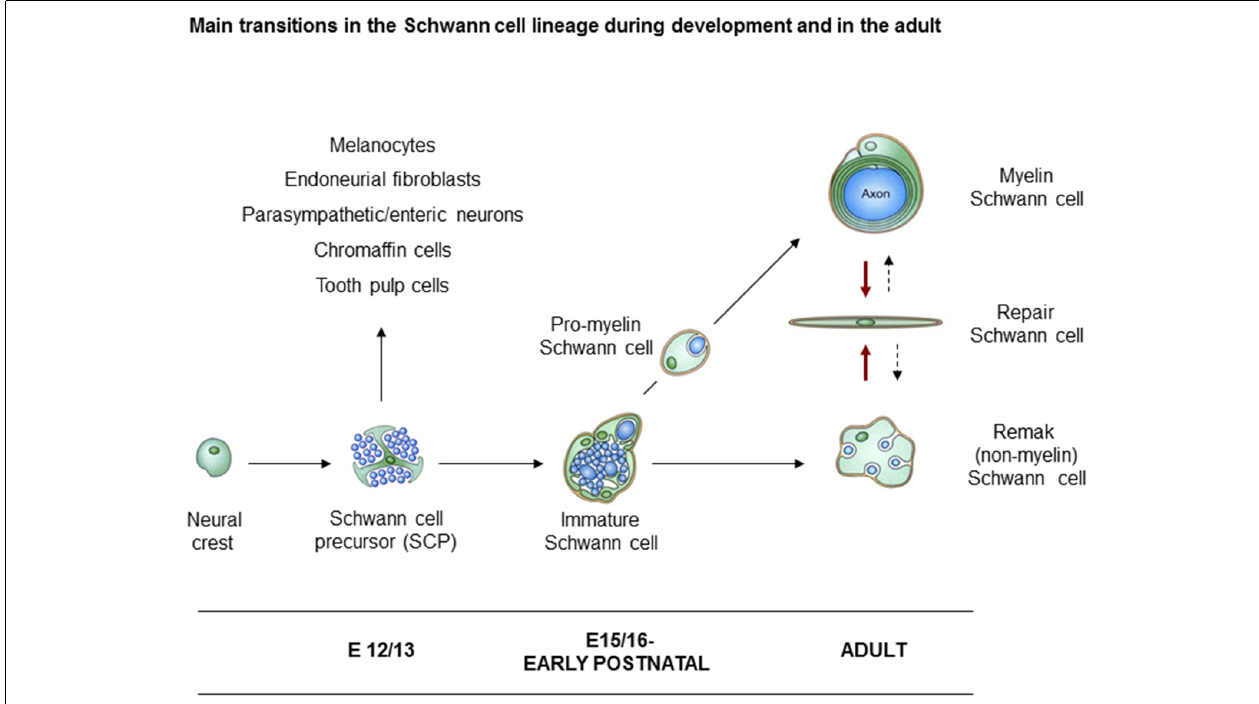
FIGURE 1 | Main transitions in the Schwann cell lineage. A scheme illustrating key cell types involved in Schwann cell development, and in nerve repair. Also shown are the alternative cells that can develop from Schwann cell precursors (SCP) in addition to immature Schwann cells (iSch). Black uninterrupted arrows: normal developmental transitions. Red arrows: the Schwann cell injury response. Stippled arrows: post-repair formation of myelin and Remak cells (with permission from Jessen et al.,